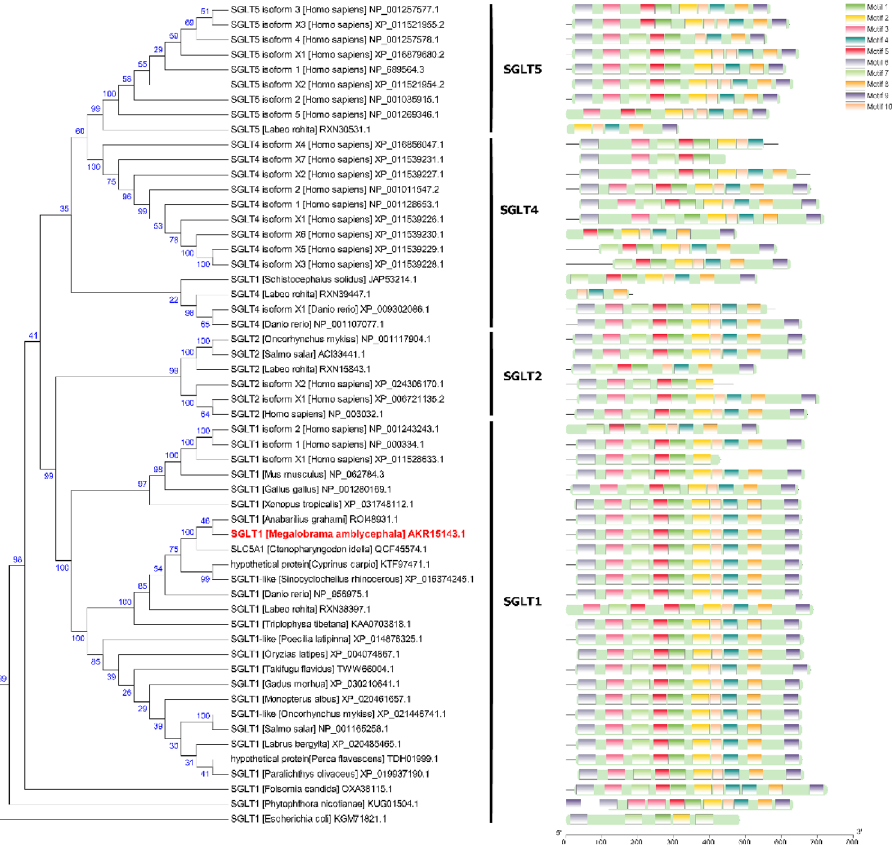
Figure 2. Evolutionary relationships of SGLT, domain and motif analyses of SGLT1 in Megalobrama amblycephala (GenBank accession no: AKR15143.1) and other